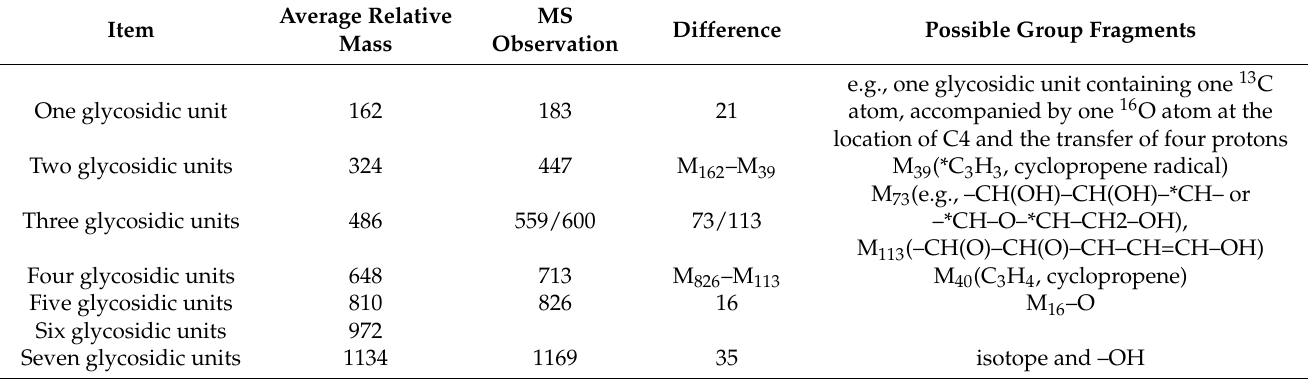
Table 3. MS Fragments of original β -CD